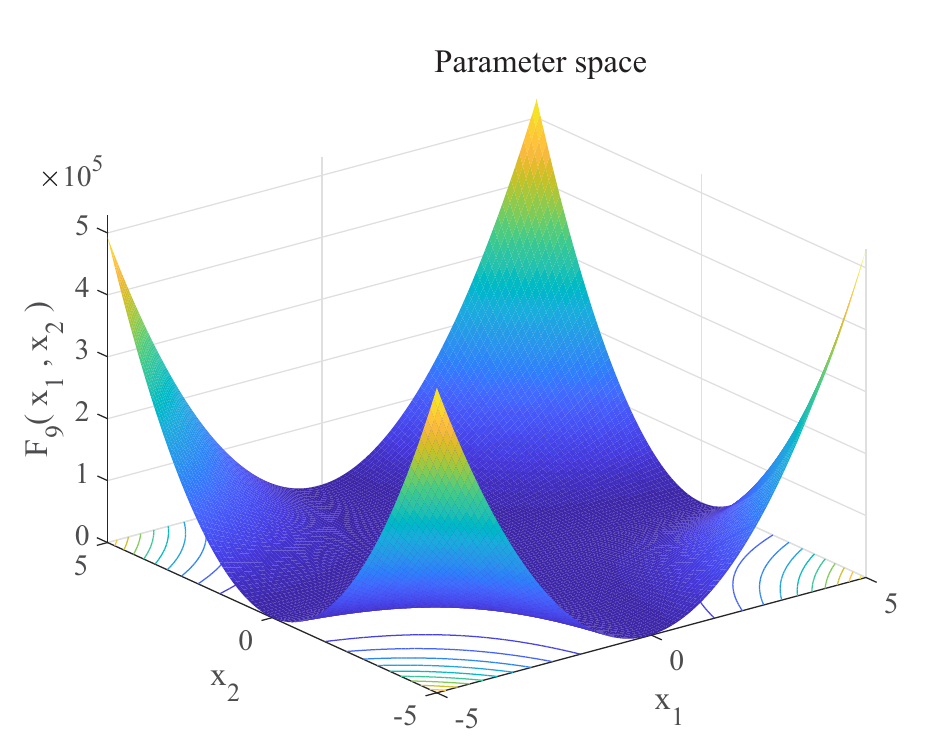
Fig 10. Three-dimensional graph of F 9 ( x